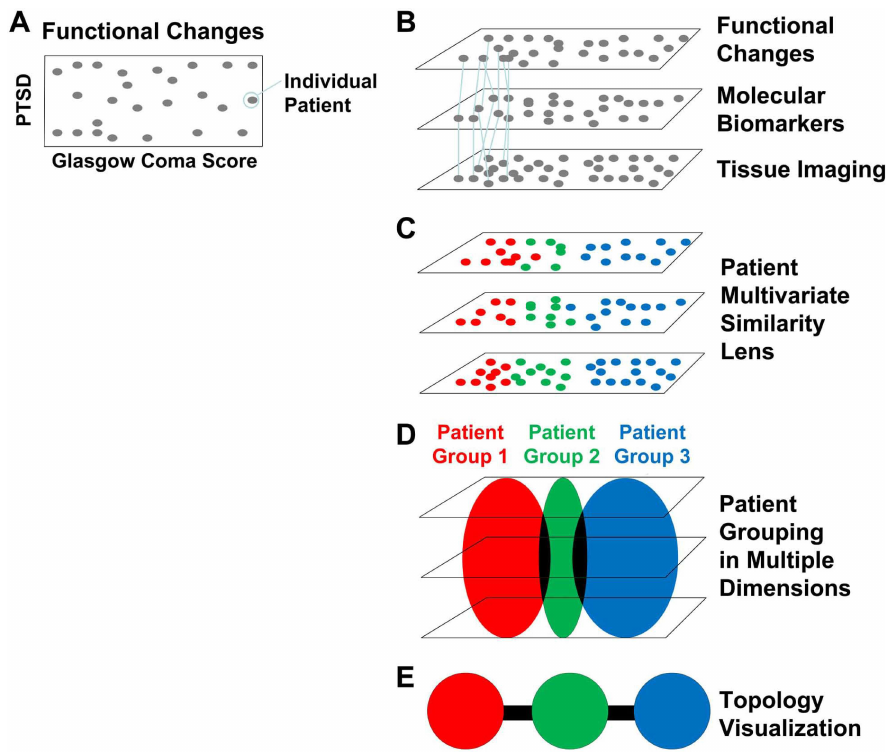
Fig 1. (A-E). Methodological work-flow for integrating diverse clinical TBI data. (A) Hypothetical exampleof a spatialbi-plot of individualpatients (grey points) on 2 functionalendpointsafter TBI (GOS-E AND PTSD). The same approach can be appliedto multiplemetrics simultaneously using multivariate pattern detectors (e.g., principalcomponentanalysis)to producea multivariate view of function. (B) In TRACK-TBI Pilot the same individuals (N = 586) were tracked prospectively across multiple domains(function, biomarkers, imaging) providingconnections (lines) across domainsto improvepatient classification using the full syndromicspace. (C) Multivariate pattern detectionlens can be used to categorize (colors) patients across all domains.(D) Patient groupingby multivariate lens. (E) Topological visualizationrenders patient groupsinto individual nodes, colored by the multivariate lens. Edges (black lines) indicateindividualsappearingin both groupsproducinga syndromic map of patient clusters.